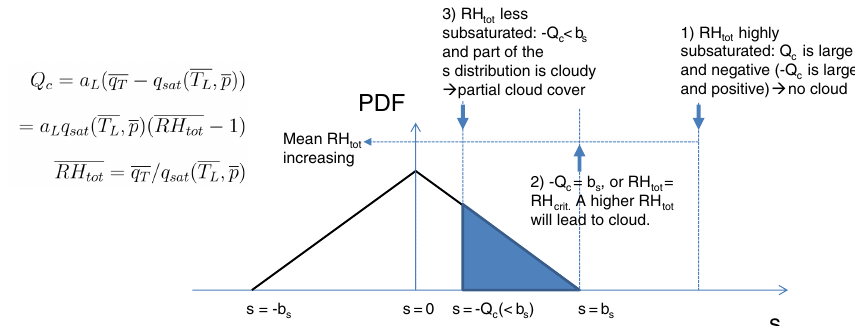
Figure A1. The assumed triangular-shaped PDF, G(s) , to represent the sub-grid distribution of s (Eq. A6), which is the liquid water mass mixing ratio associated with perturbations about the mean grid-box state (for which s = 0). The half-width of the distribution is called b s and is a specified parameter. Cloud forms for the part of the distribution for which q L > 0, which corresponds to s > − Q c (Eq. A3) if − Q c < b s , G(s) d s (shaded part of the figure; note that the shading applies to situation (3) as labelled in the figure, with the cloud fraction given by R b s − Q c i.e. − Q c < b s ). Q c is the amount of total water content above saturation for the grid-box mean state and thus increases as the grid-box mean total water relative humidity (RH tot ) increases. For highly sub-saturated mean conditions (in terms of RH tot ), Q c is large and negative such that − Q c > b s and no part of the sub-grid distribution is cloudy (see (1) in the figure). With increasing RH tot , a critical relative humidity (denoted as RH crit ) is reached (2), where − Q c = b s . Further increases in RH tot will lead to partial cloud coverage (e.g. (3)) with full cloud cover only being reached when Q c = b s , corresponding to RH tot > 1.